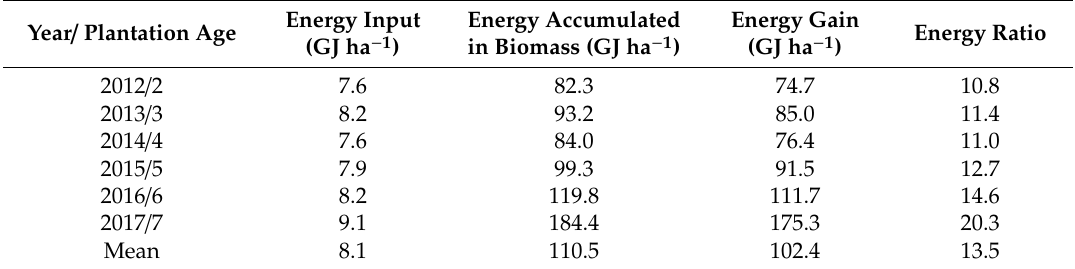
Table 4. Energy-e ffi ciency indicators of Silphium perfoliatum production as feedstock for solid biofuels in six successive harvest rotations, harvested at the end of March; based on Stolarski et al. [106]. Energy Input Energy Accumulated Energy Gain Year / Plantation Age (GJ ha − 1 ) in Biomass (GJ ha − 1 ) (GJ ha − 1